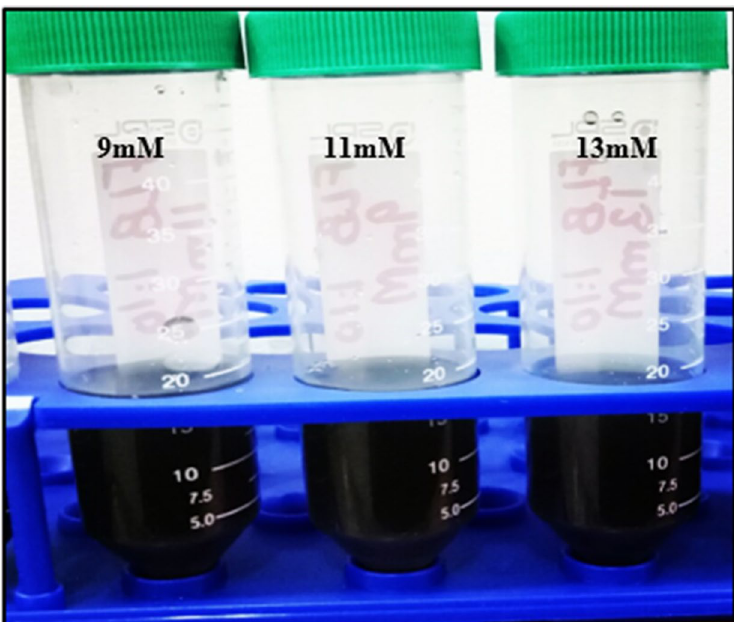
Figure 1. Iron Nanoparticles synthesized by Phoenix dactylifera leaves